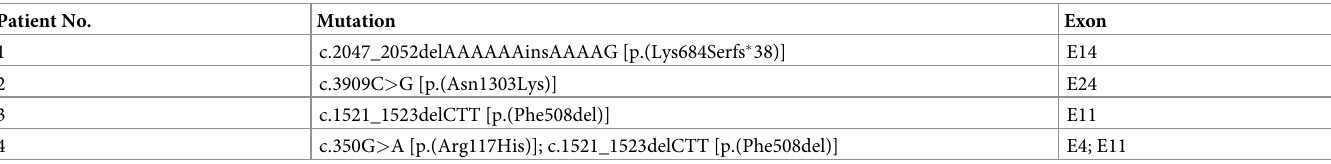
Table 2. Pathological mutations described in the analysed population with asthma. Patient